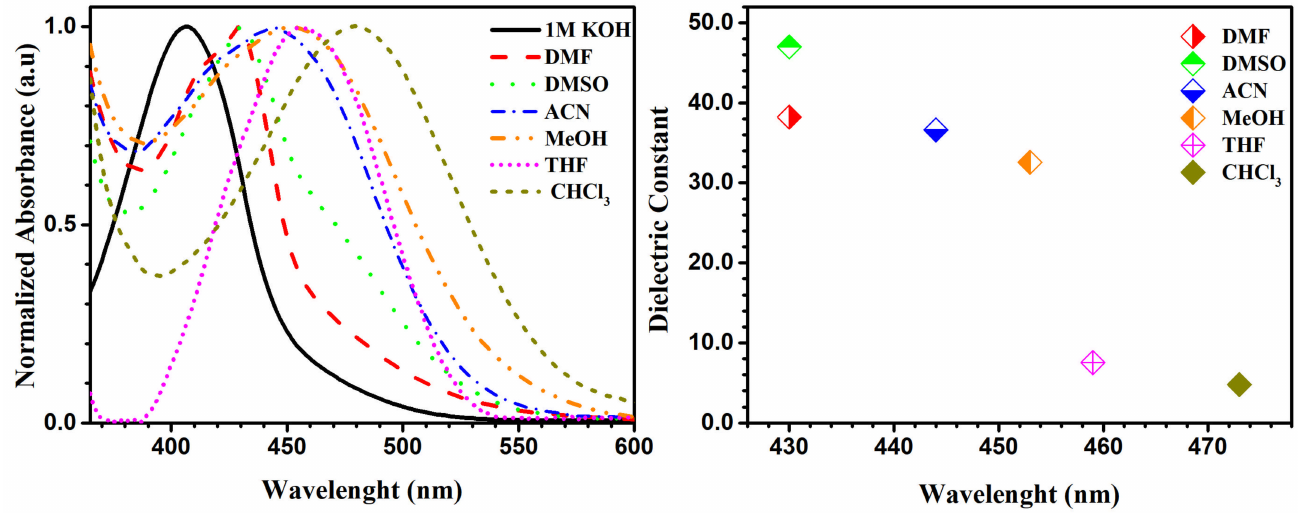
Figure 7. UV-Vis absorption spectra (left), plot of the dielectric constant of solvent against wavelength of 5b (right). In the 1 H-NMR spectra in DMSO and CDCl 3 polar solvents, we observed only ni- troso form 5b . However, after the addition of a drop of KOD solution of D 2 O to